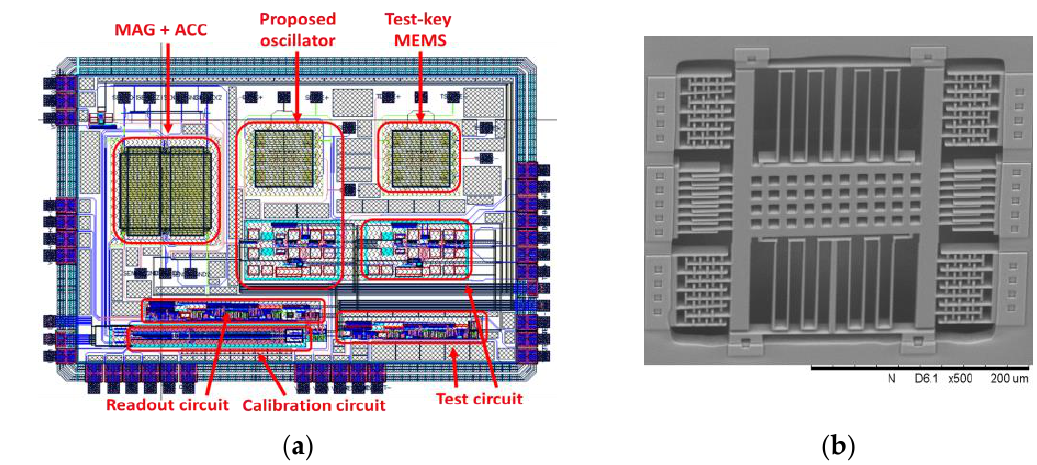
Figure 13. ( a ) Layout view of chip; ( b ) scanning electron microscope view of proposed MEMS os- cillator.